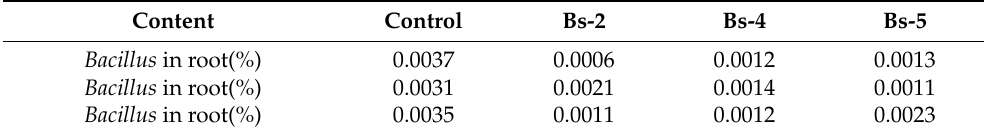
Table A1. Saprophytic Bacillus effected on the root of Aquilaria sinensis .